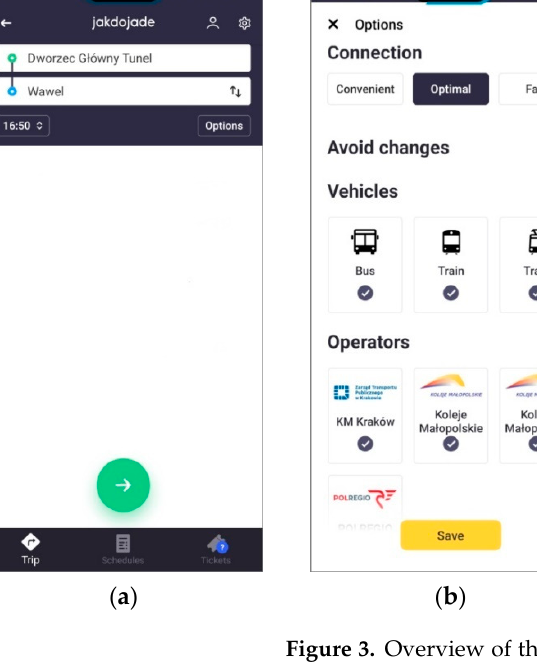
Figure 3. Overview of the Jakdojade application tabs: ( a ) selection of starting points and destina- tions; ( b ) options for selecting the type of route, means of transport and public transport operators; ( c ) routing options; ( d ) detailed information on the selected